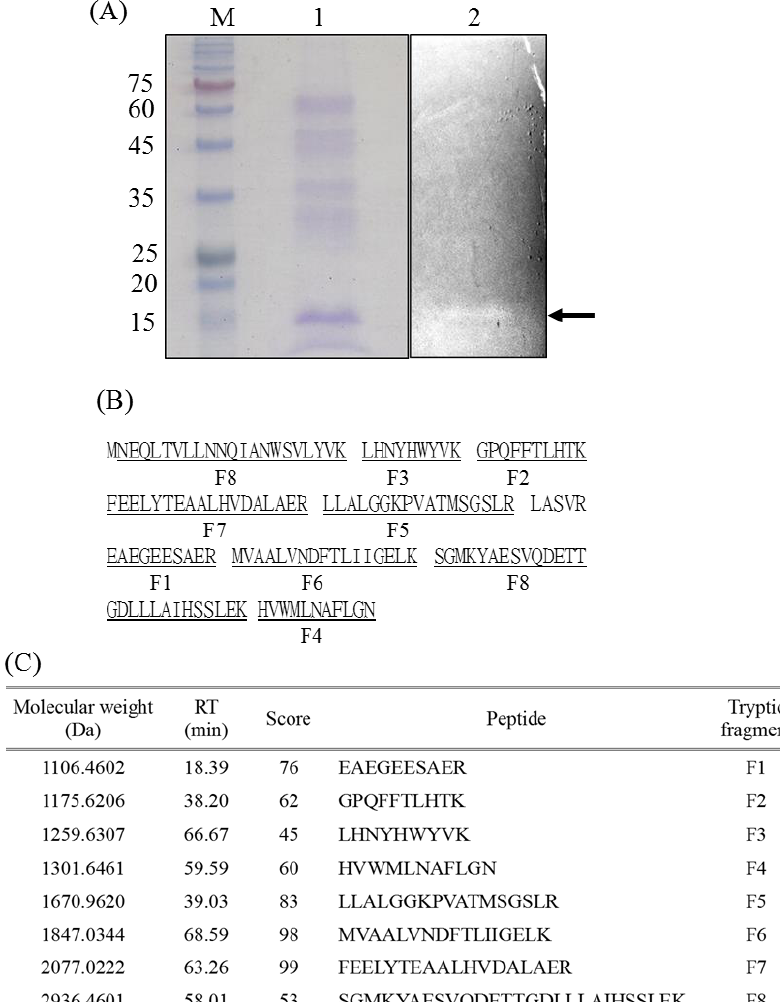
Figure 1. Characterization of the bacteriocin-like substance from Paenibacillus ehimensis NPUST1. ( A ) Gel overlay analysis. Lane M: marker; lane 1: SDS-PAGE analysis of ammonium sulfate-precipitated cell-free culture broth of P. ehimensis NPUST1; lane 2: SDS-PAGE gel placed on a TSB agar surface overlaid with Aeromonas hydrophila . The arrow indicates the antimicrobial protein; ( B ) Tryptic peptide map of the bacteriocin-like substance; ( C ) Identification of tryptic peptides derived from the bacteriocin-like substance by LC-MS/MS analysis. Peptides with ion scores greater than the identity threshold (score > 45) were regarded as identified peptides.